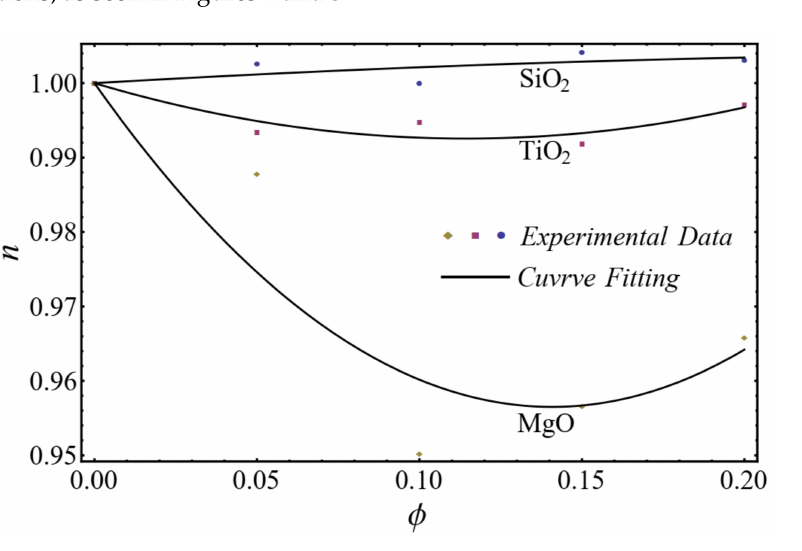
Figure 4. Curve fitting with experimental data for power-law index by using Equation